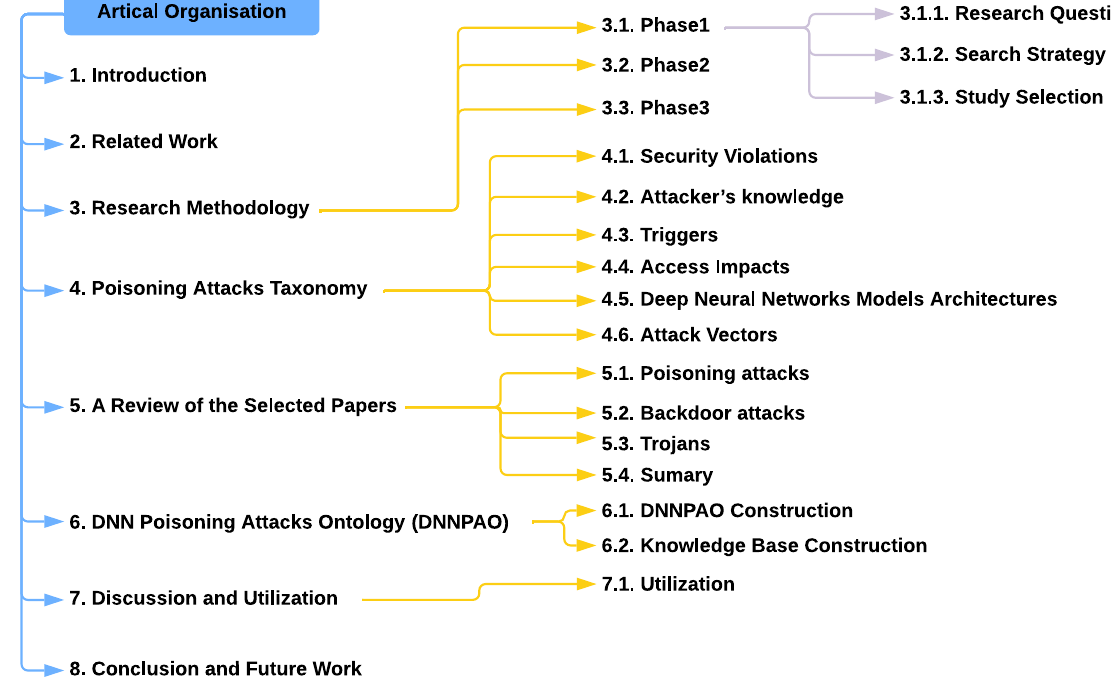
Figure 1. Article